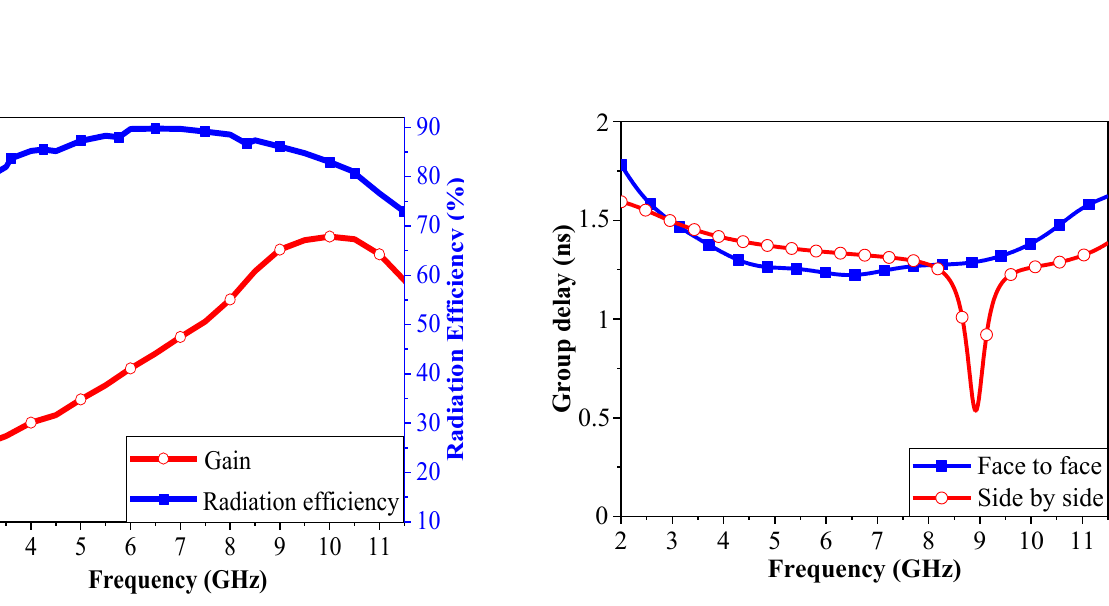
FIGURE 13. Simulated group delay in both configurations (Face-to-face and side-by-side).